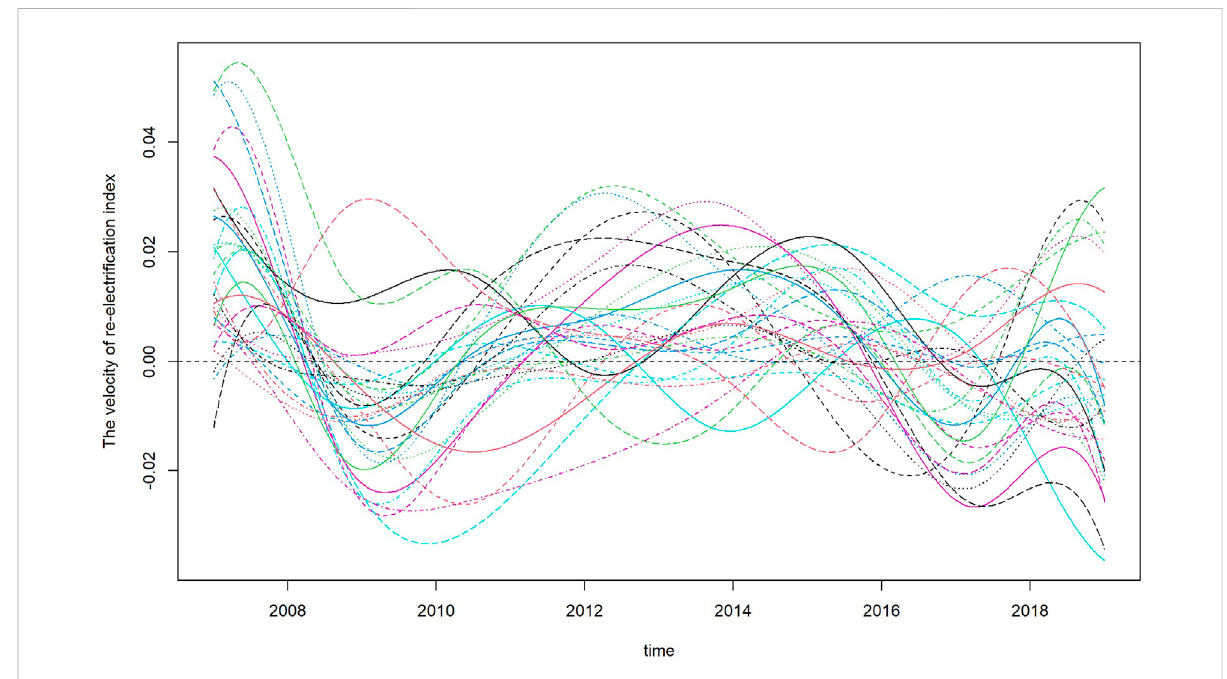
FIGURE 2 Velocity curve of the re-electri fi cation index.